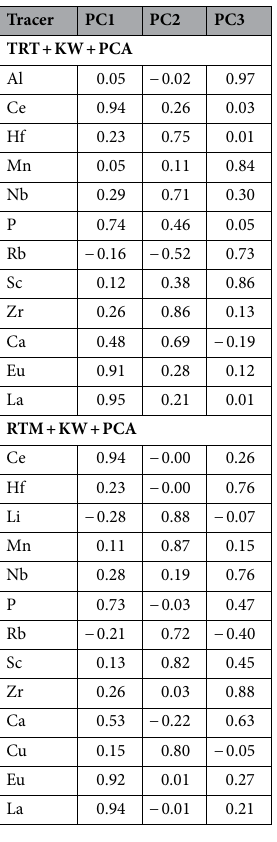
Table 3. Results of PCA based on tracers passing TRT + KW and RTM +